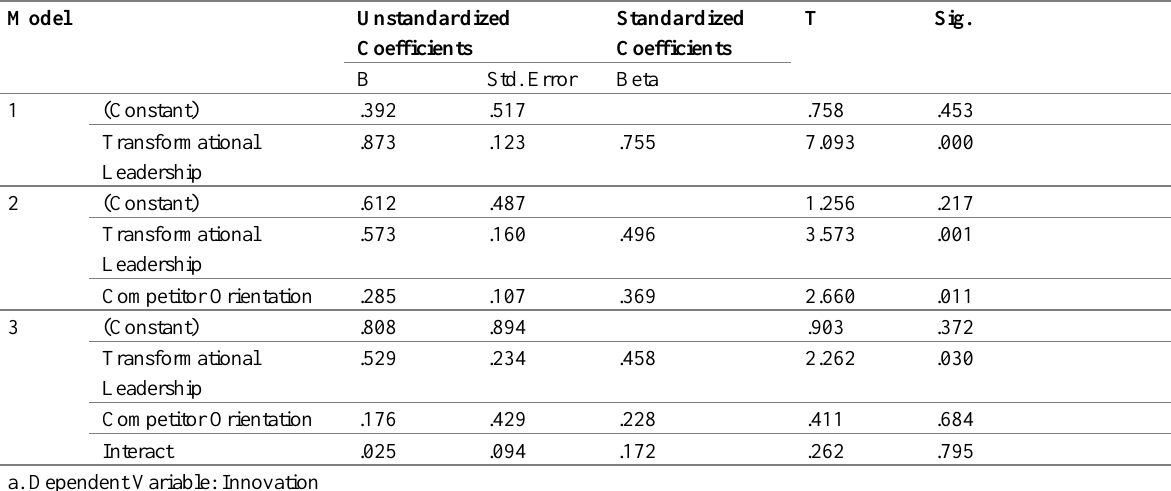
Table 5: Coefficients